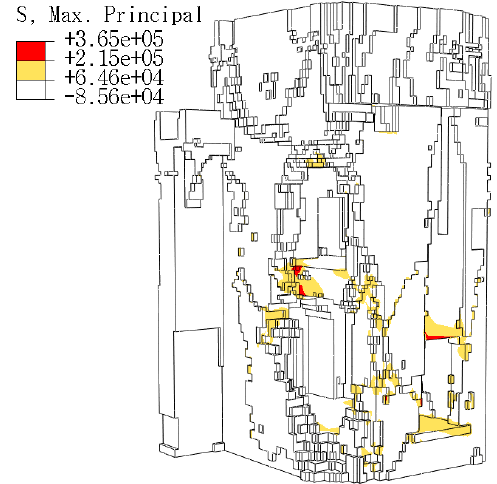
Figure 9. Maximum principal stress contour plot (Pa).